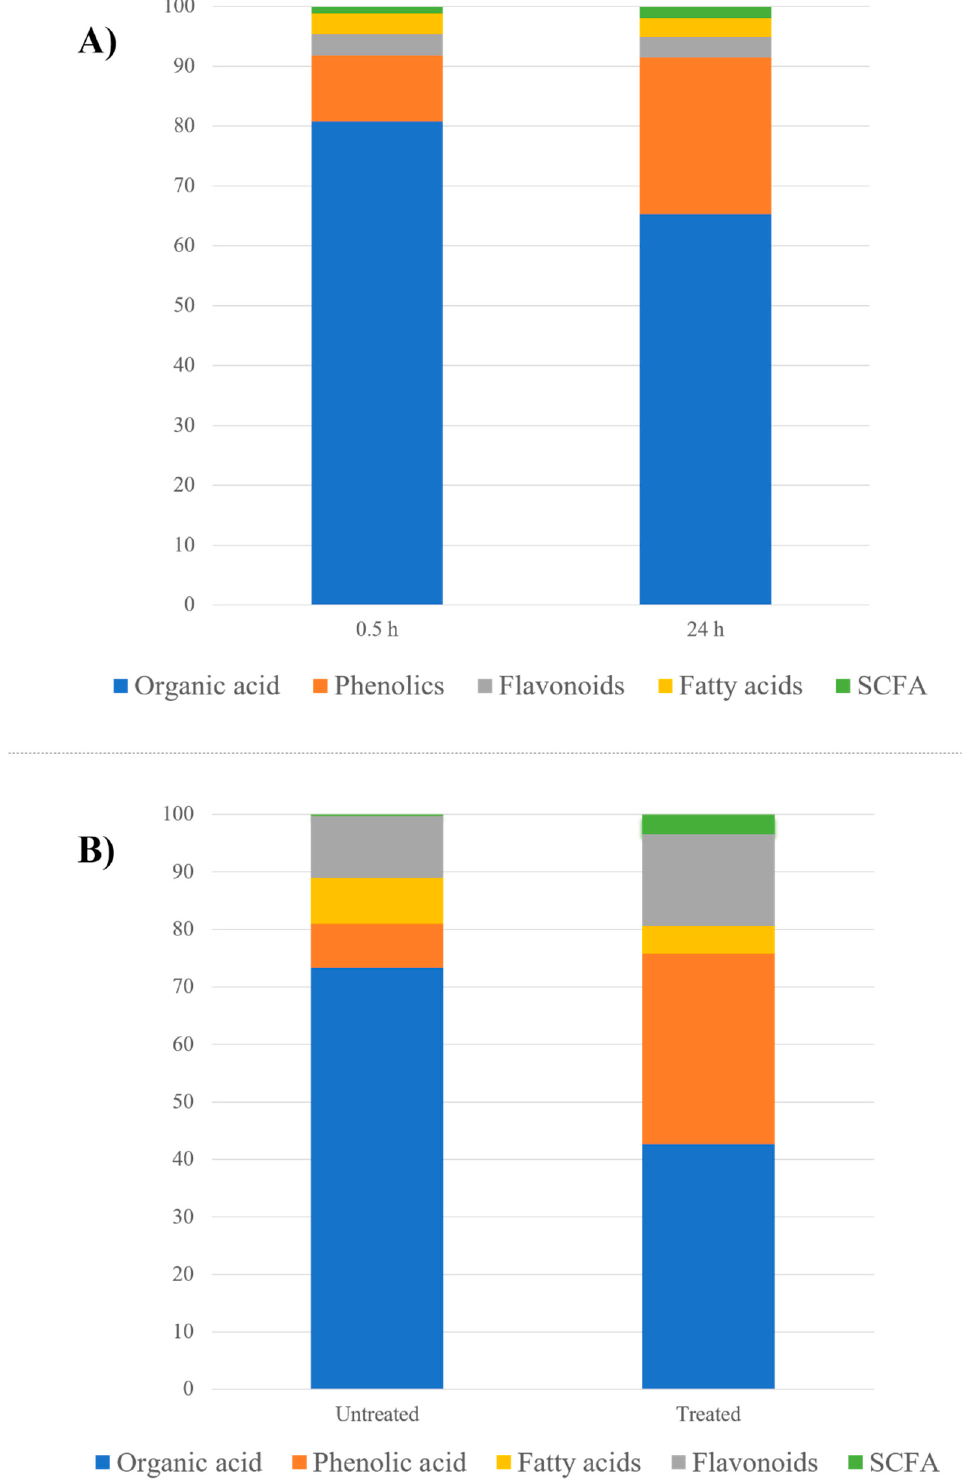
Figure 2. Bar chart showing changes in metabolite classes relative percentile levels set to 100% in O. ficus samples ( A ) treated in vitro at two time intervals, 0.5 and 24 h, with gut microbiota and ( B ) ex vivo untreated vs. treated samples with human fecal bacterial culture.